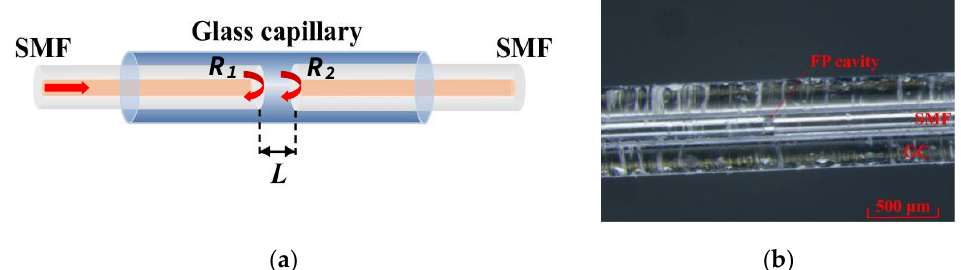
Figure 1. Typical structure of a fiber-optic FP sensor. ( a ) Schematic diagram, ( b ) micrograph of a FP sensor.